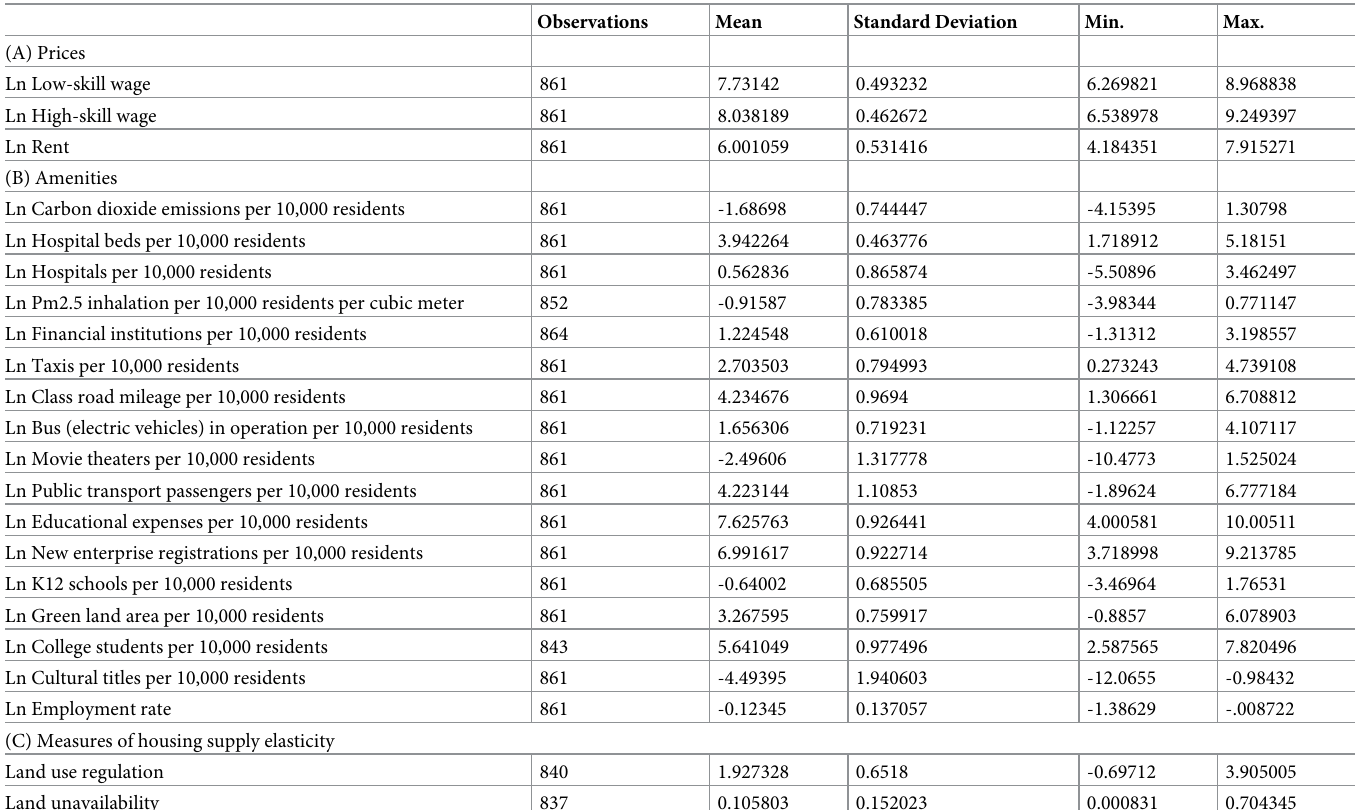
Table 1. Summary statistics.